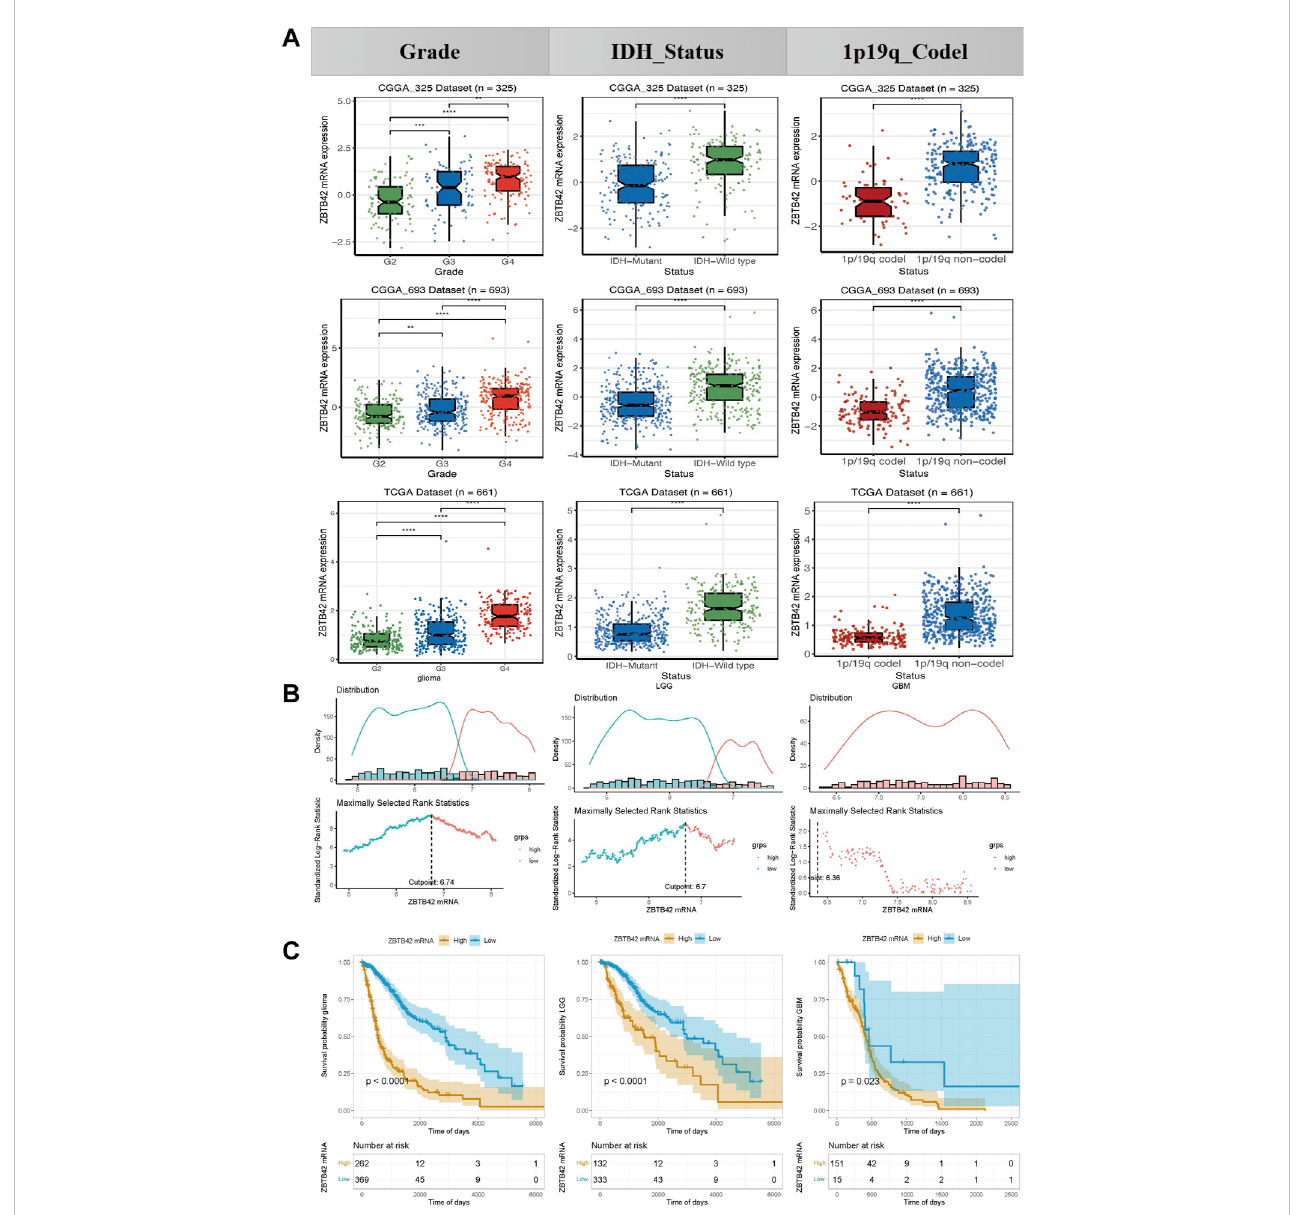
FIGURE 2 ZBTB42expressionindifferentsubgroupsofgliomaandcorrelatedwithtumorprogression. (A) ExpressionofZBTB42inclinicalsubgroupsofglioma. (B) Optimalcutpointdeterminationinglioma,LGG,andGBM. (C) HighexpressionofZBTB42leadstopoorprognosisinbothLGGandGBM.* p < 0.05;** p < 0.01; *** p < 0.001; **** p <